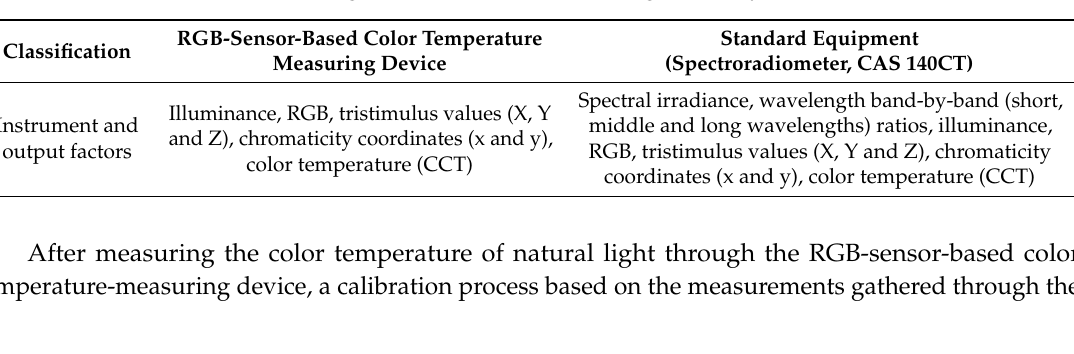
Table 5. Natural light characteristics that can be gathered by each